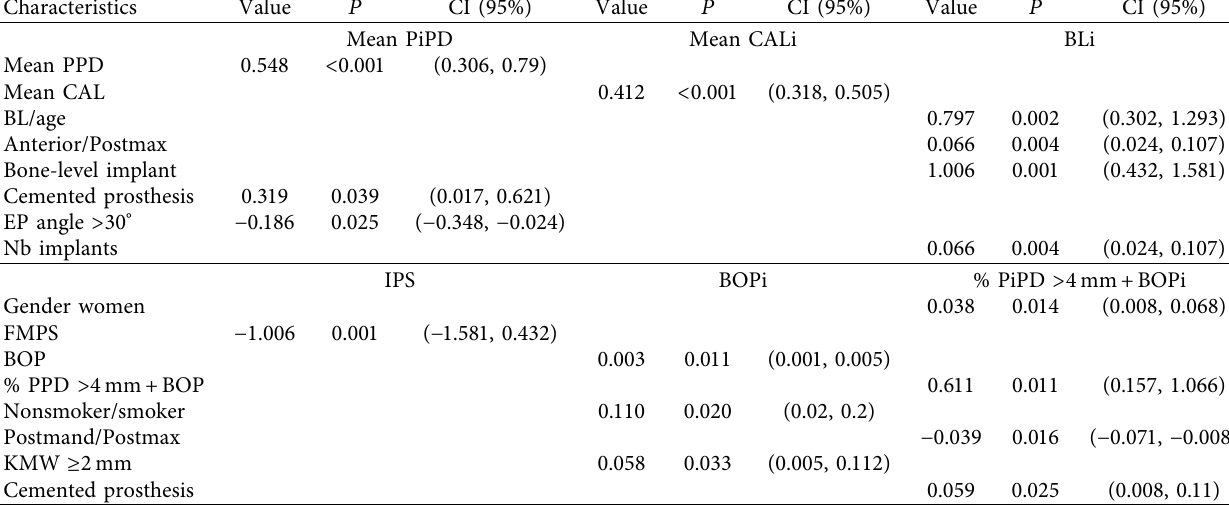
Table 5: Multivariable regression analysis of associations between the periodontal, implant, prosthesis, and peri-implant tissue charac- teristics at the implant